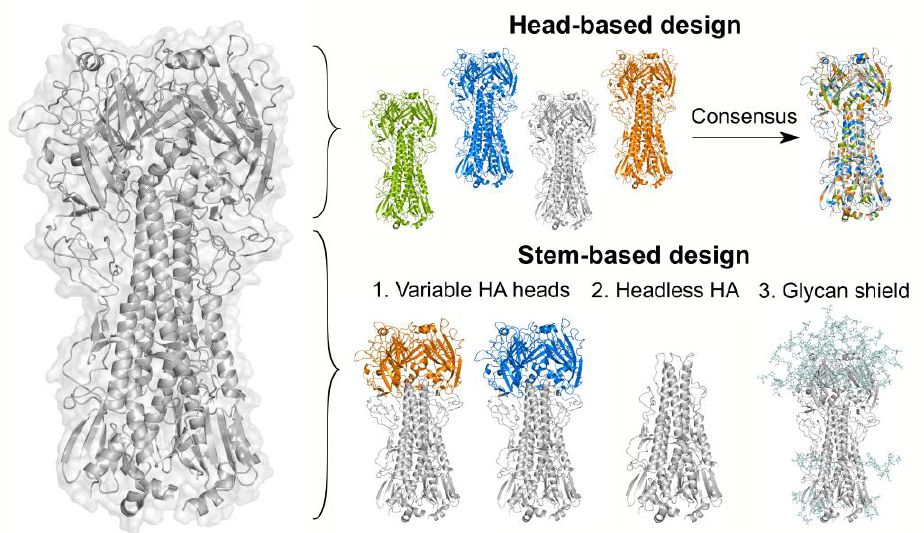
Figure 6. Strategies to design broadly reactive HA-based influenza vaccines. The top panel depicts the COBRA design technology. The COBRA strategy uses diverse HA sequences and multiple rounds of consensus sequence calculations to generate a unique immunogen that can elicit head-targeting antibodies. The bottom panel shows the main protein-design approaches to redirect the immune response towards the conserved HA stem domain. These strategies include (1) chimeric HA constructs consisting of a conserved HA stem domain (gray) and distinct HA heads from viruses absent in humans (blue and orange regions); (2) headless HA proteins designed by removing the HA head domain and introducing stabilizing substitutions at the stem; (3) modifications of HA glycosylation sites to hide immunodominant epitopes at the HA head domain (e.g., hyperglycosylation of the head domain). In this panel, the HA protein is shown in gray, while glycans are shown in light blue. The glycans displayed are an artificial representation of this strategy and were drawn using GlyProt [142]. All figures were produced using PyMol [143] and the PDB 4m4y